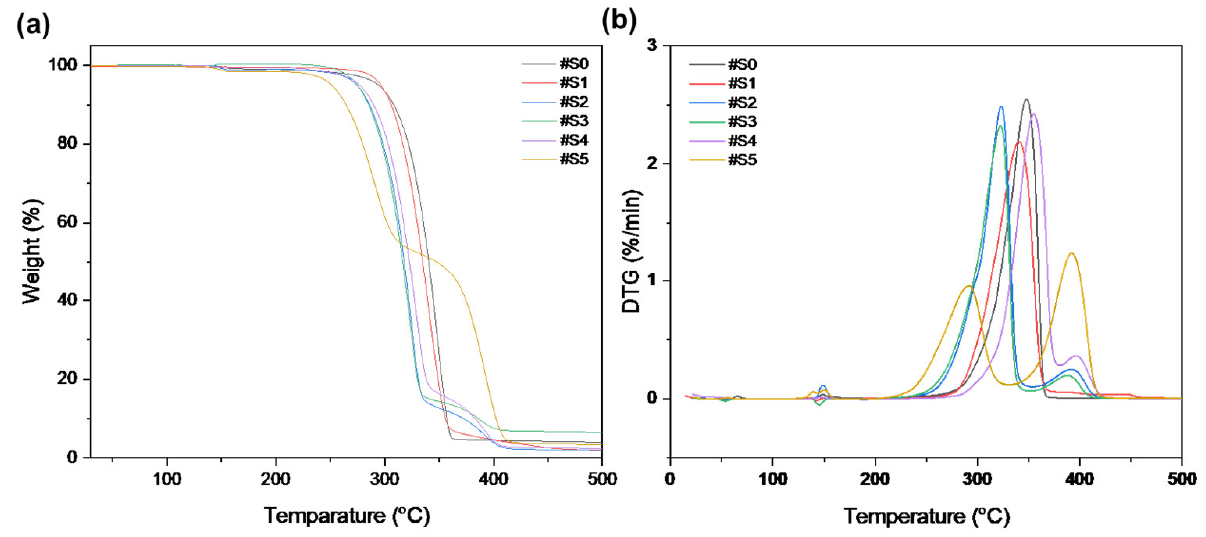
Figure 6. ( a ) TGA and ( b ) DTG curves of #S0, #1S, #2S, #3S, #S4, and #S5. Table 2. TGA results of #S0, #1S, #2S, #3S, #S4, and #S5.